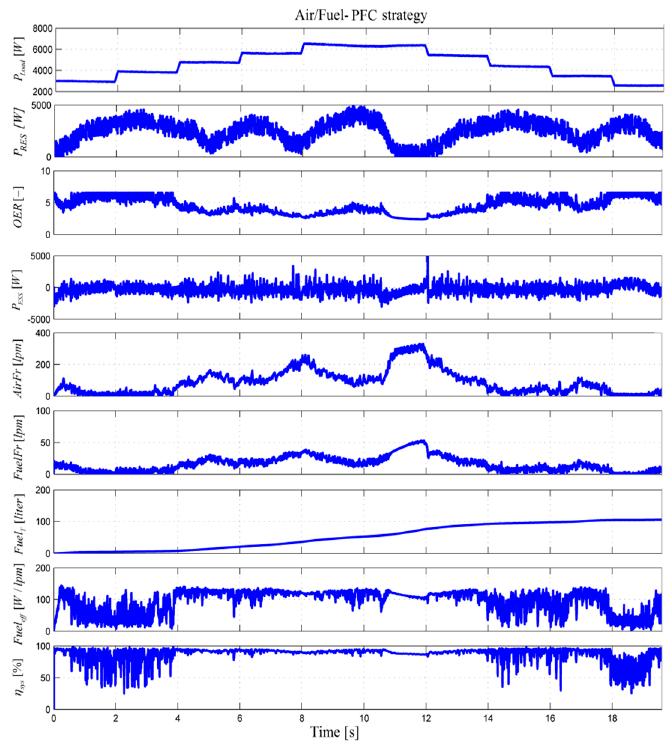
/ renewable HPS behavior using air / fuel-PFC strategy. Figure 13. FC/renewable HPS behavior using air/fuel-PFC strategy. Figure 13. FC